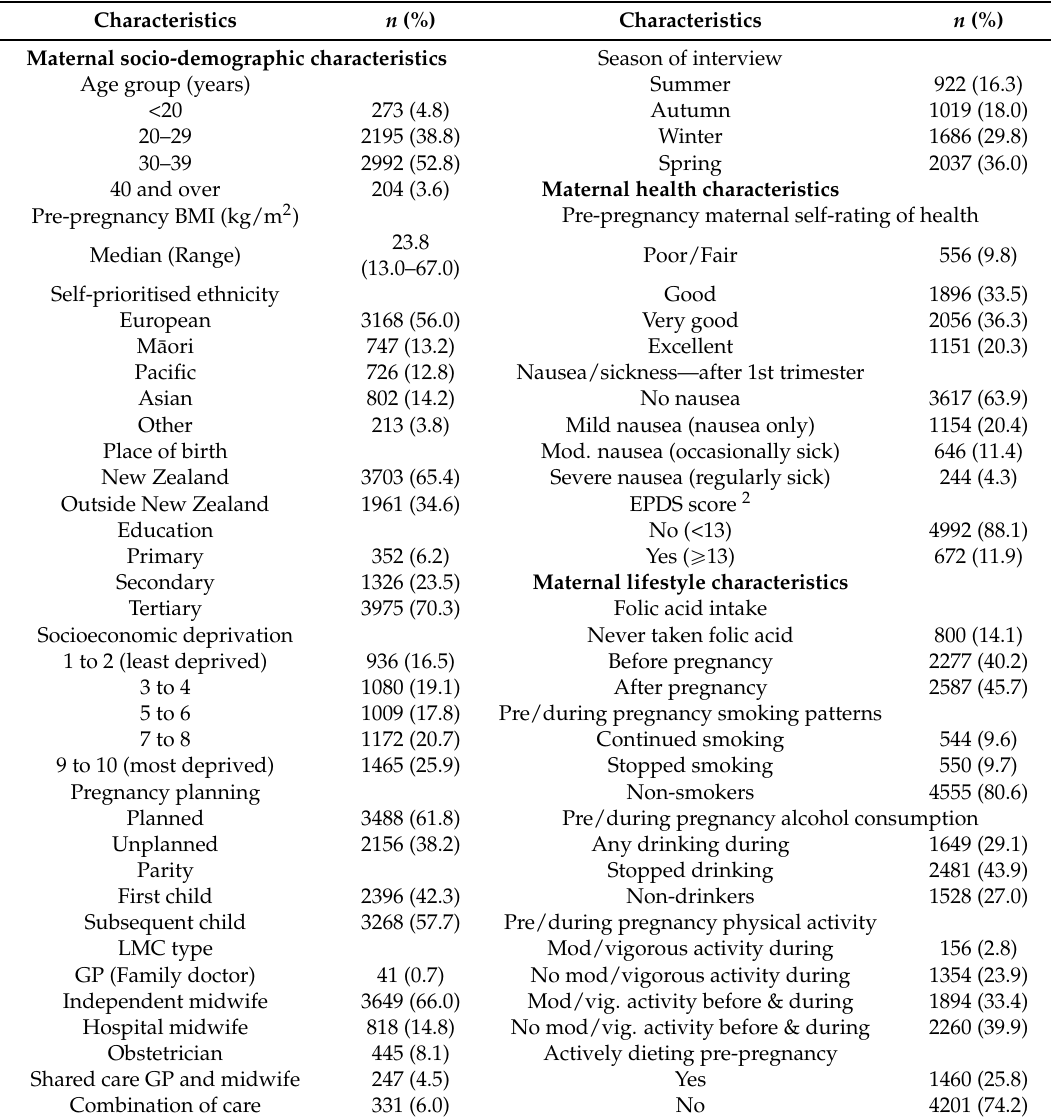
Table 1. Participant socio-demographic, health and lifestyle characteristics 1